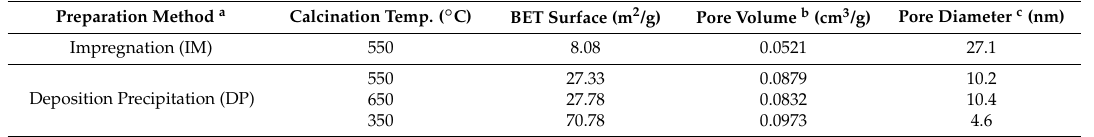
Table 1. Textural properties of catalysts prepared by different methods.